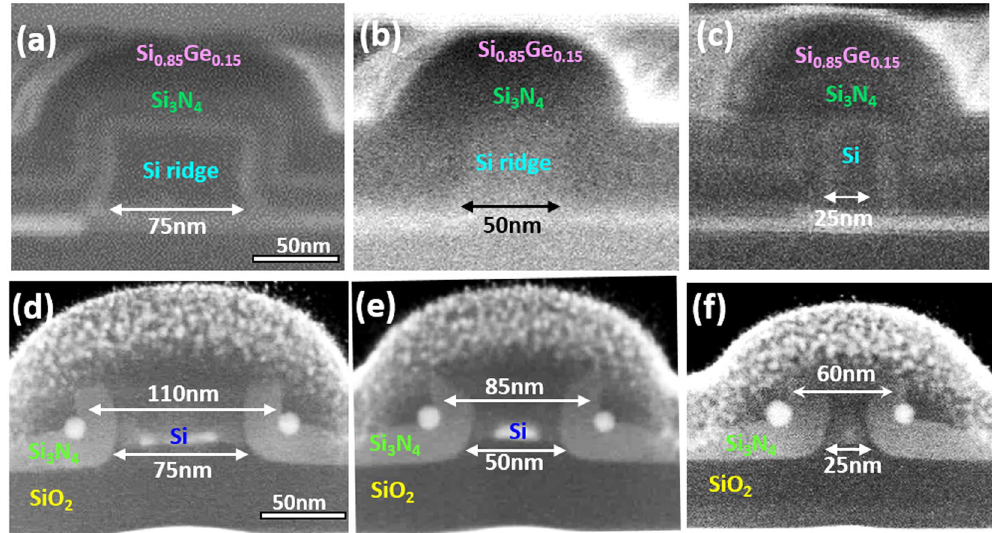
Figure 4. Cross-sectional SEM and TEM micrographs of 12 nm Ge DQDs formed by thermal oxidation at 900 °C for 10.5 min. The width of poly-Si ridges is decreased from ( a ) 75 nm, ( b ) 50 nm, and to ( c ) 25 nm, and the inter-dot spacing correspondingly decreases from ( d ) 110 nm, to ( e ) 85 nm, and to ( f ) 60 nm.